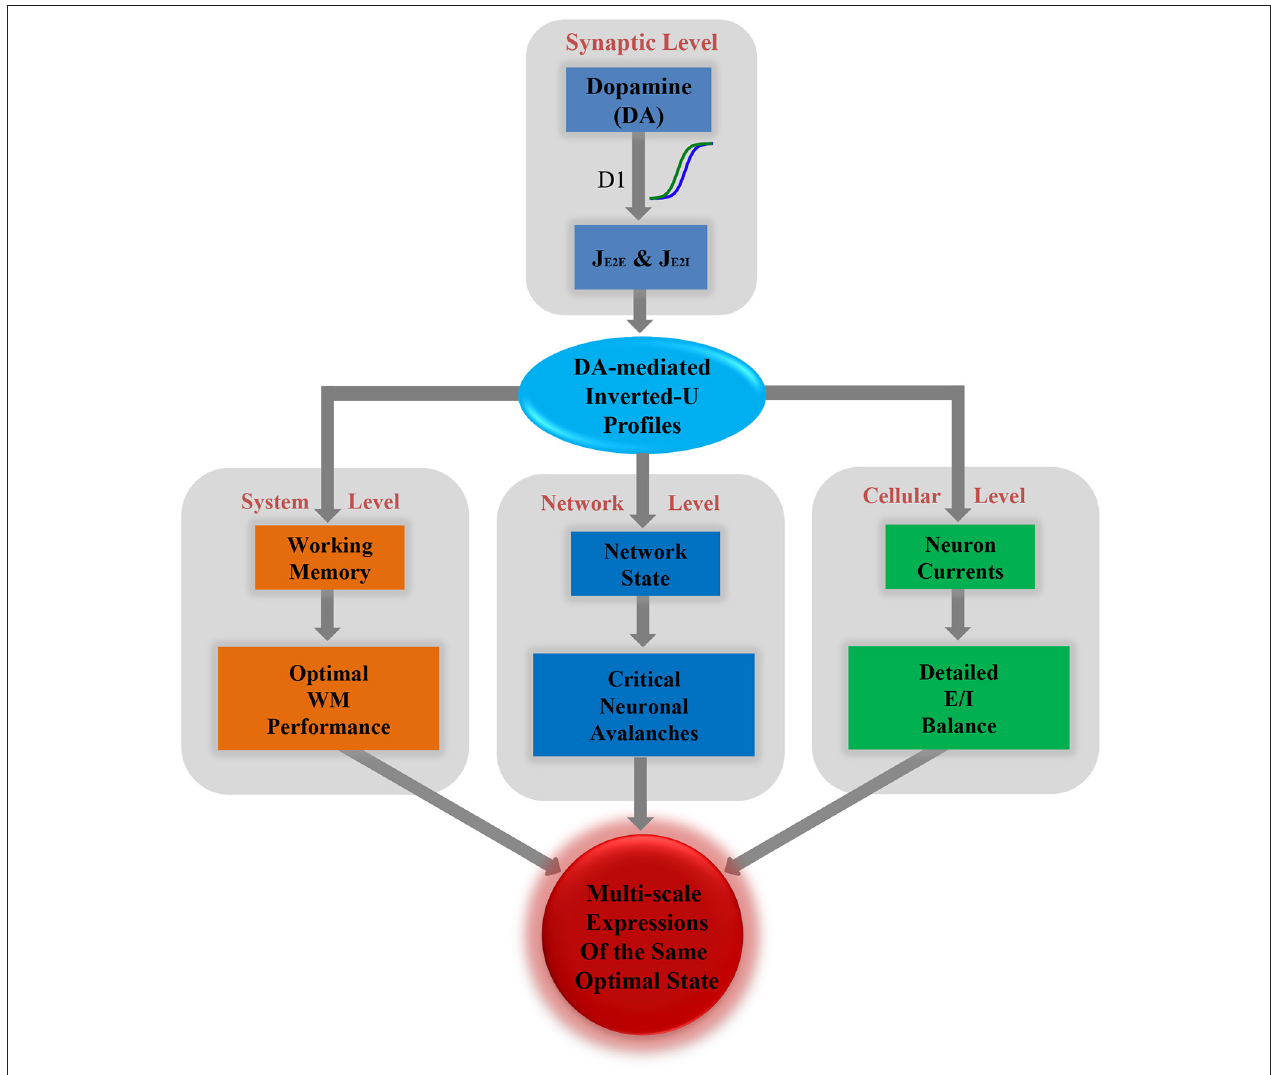
FIGURE 5 | Multi-scale expressions of the same optimal state regulated by dopamine, including detailed E/I balance at the cellular level, critical dynamics at the network level, and optimal WM performance at the system level.